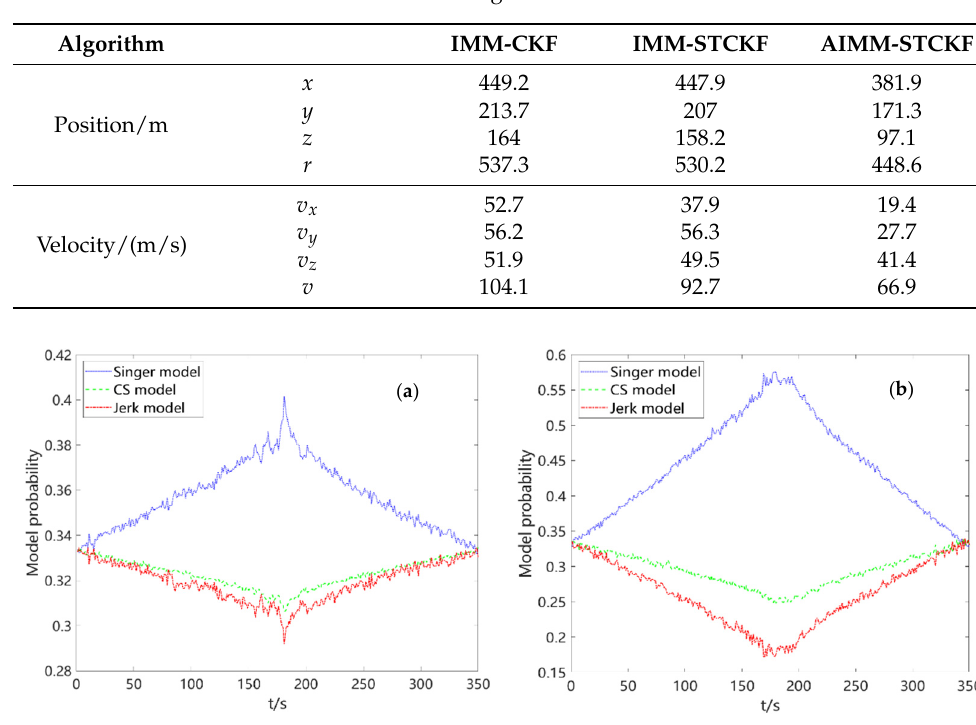
Table 1. Table of the mean RMSEs of the three algorithms.